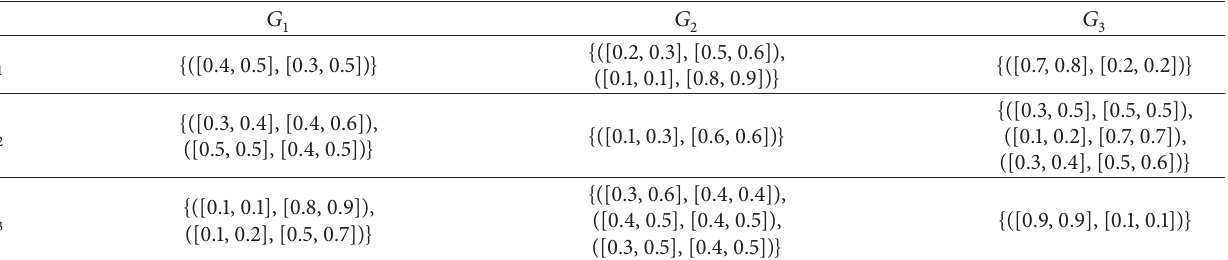
Table 7: The interval-valued intuitionistic hesitant fuzzy decision matrix